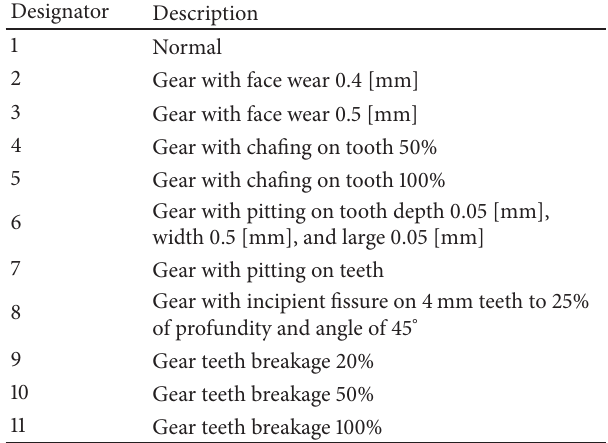
Table 3: Nomenclature of gears fault.